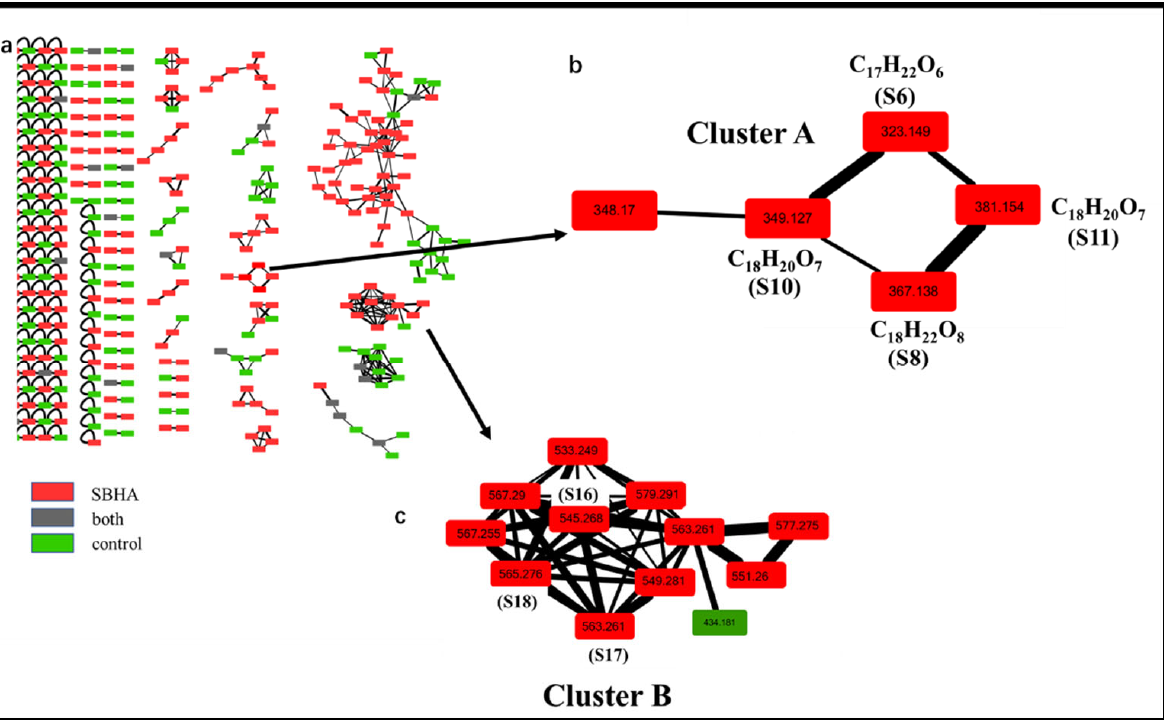
Figure 4. Molecular network analysis of newly discovered features after CER. ( a ). Global molecular network of all extracts; ( b ). Cluster A including 4 newly induced main features (m/z 323.149, 349.127, 367.138, 381.154); ( c ). Cluster B including 3 newly induced main features (m/z 545.268, 563.261, 565.276).